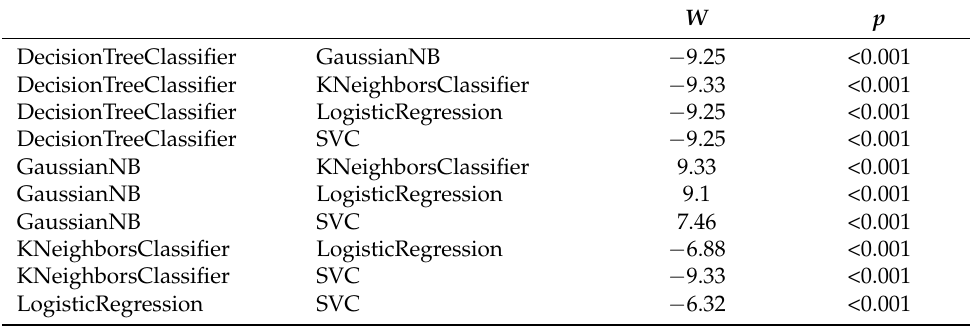
Table A9. The results of the Dwass-Steel-Critchlow-Fligner pairwise comparisons for test AUC